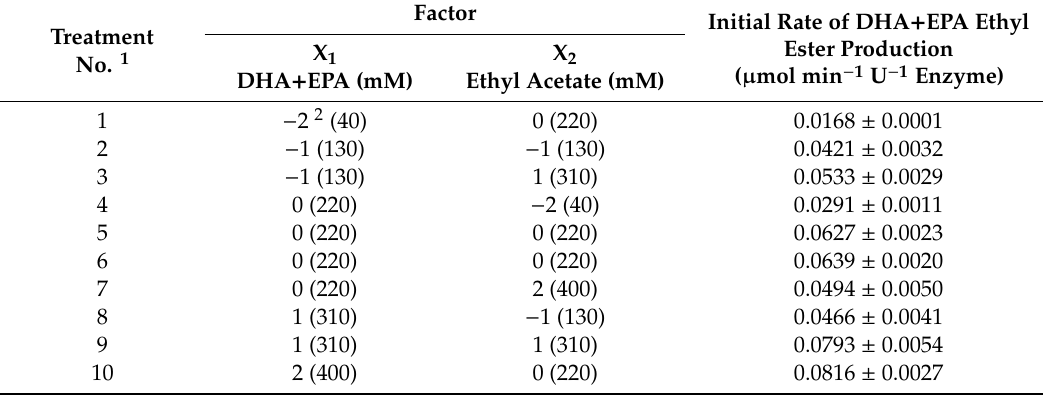
Table 1. Central composite design and initial experimental rate of DHA + EPA ethyl ester production.